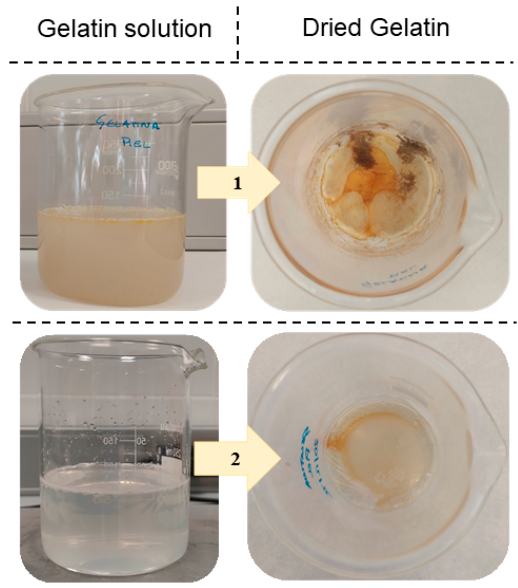
Figure 3. Result of applying an activated carbon filtration step in the production of fish gelatin (2) and without filter (1).